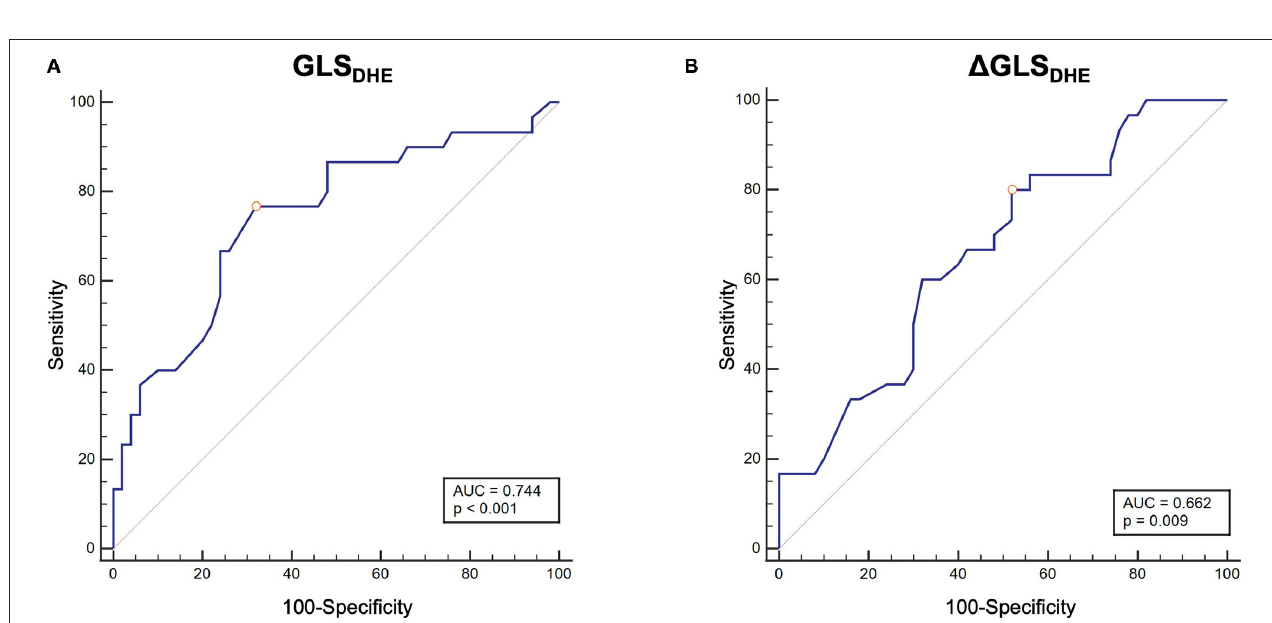
FIGURE 6 | ROC-curve analyses for the differentiation between healthy individuals and patients with CAD. (A) GLS DHE : cut-off value > –20.6%. AUC = 0.744, p < 0.001, sensitivity 76.7%, specificity 68.0%. (B) 1 GLS DHE (absolute difference between GLS at rest and after DHE): cut-off value > –1.7%. AUC = 0.662, p = 0.009, sensitivity 80.0%, specificity 48.0%. ROC, receiver operating characteristic; CAD, coronary artery disease; GLS, global longitudinal strain; AUC, area under the curve; DHE, dynamic handgrip exercise.